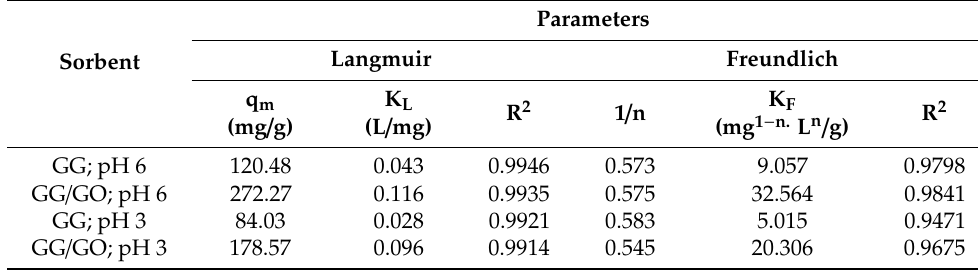
Table 2. Fitting parameters for Langmuir and Freundlich isotherms of Zn (II) sorbed on GG and GG / GO.